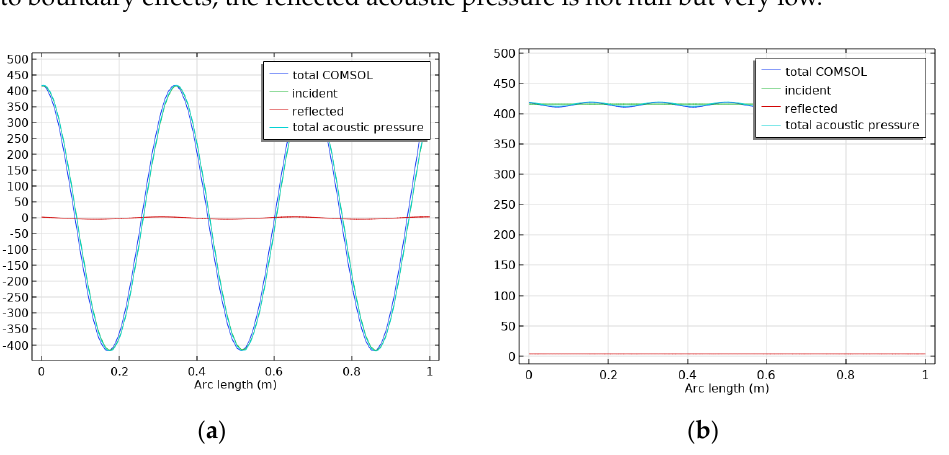
Figure 6 . Plate-patch system: ( a ) transducer mounted directly to the plate surface. Such a configu- ration is referred to as a bonded configuration. The bonded configuration is an excellent choice for sensing or creating vibrations in a relatively stiff structure. Transducers in this configuration can be used to monitor vibrations caused by an outside source, section of the plate and ( b ) axonometry of the tube with the applied piezoelectric patch represented by the radius where the moment is applied in the negative z-direction.